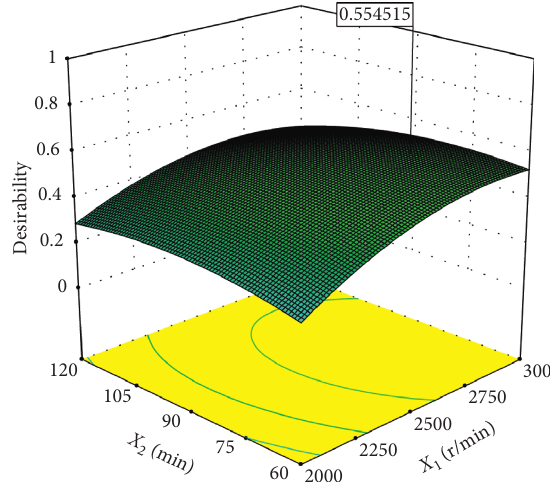
Figure 11: Effect of interaction factors on the yield of 120 mesh phenolic resin powder. (a) X X 4 � 60g. (c) X 2 � 90min, X 3 � 0.85mm. (d) X 1 � 2500r/min, X 4 � 60g. (e) X 1 � 2500r/min, X 3 � 0.85mm. (f) X 1 � 2500r/min, X 2 � 90min.